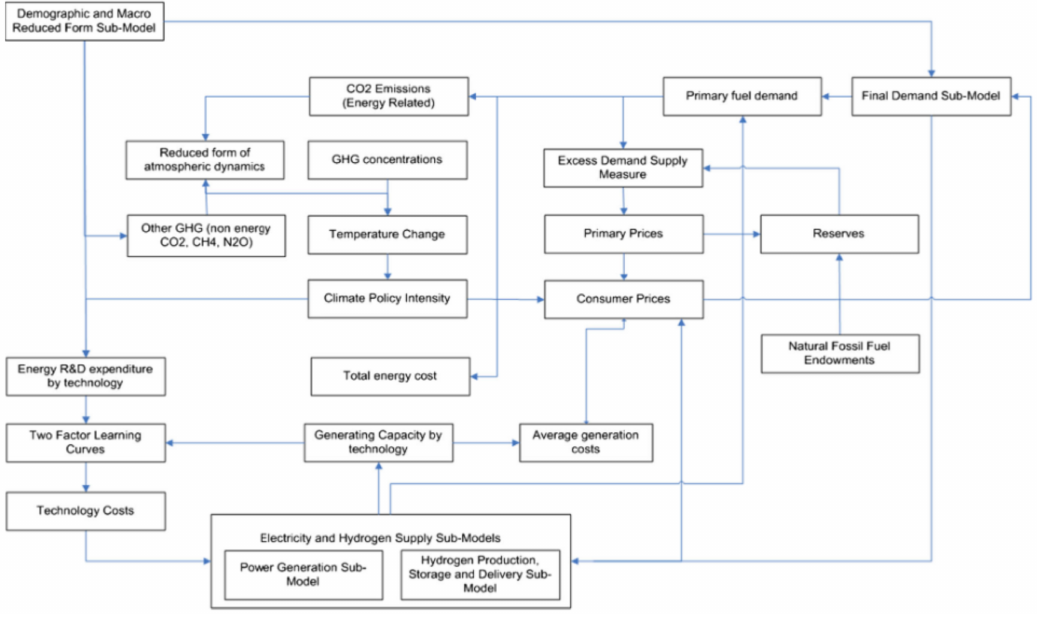
Figure 1. PROMETHEUS flow